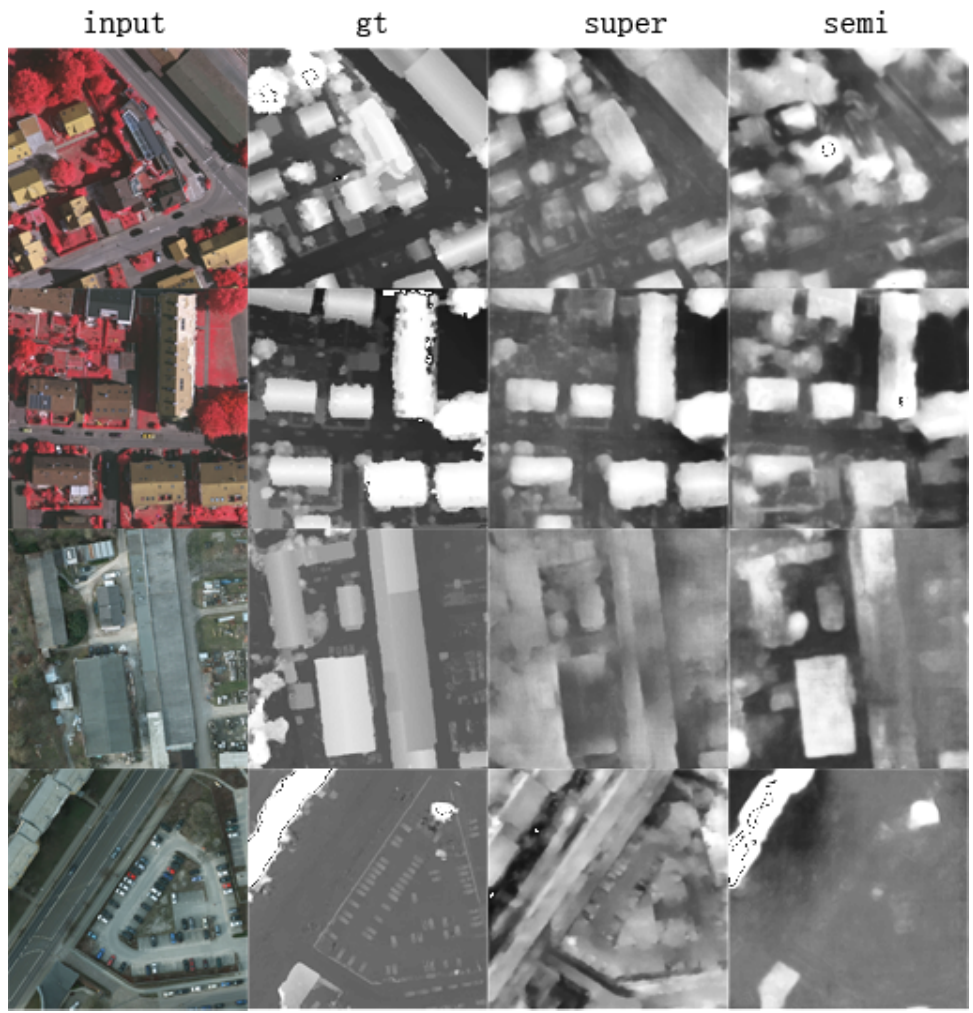
Figure 6. Inter-domain semi-supervised visualization. From left to right are input images, ground truths, supervised learning predictions, and semi-supervised learning